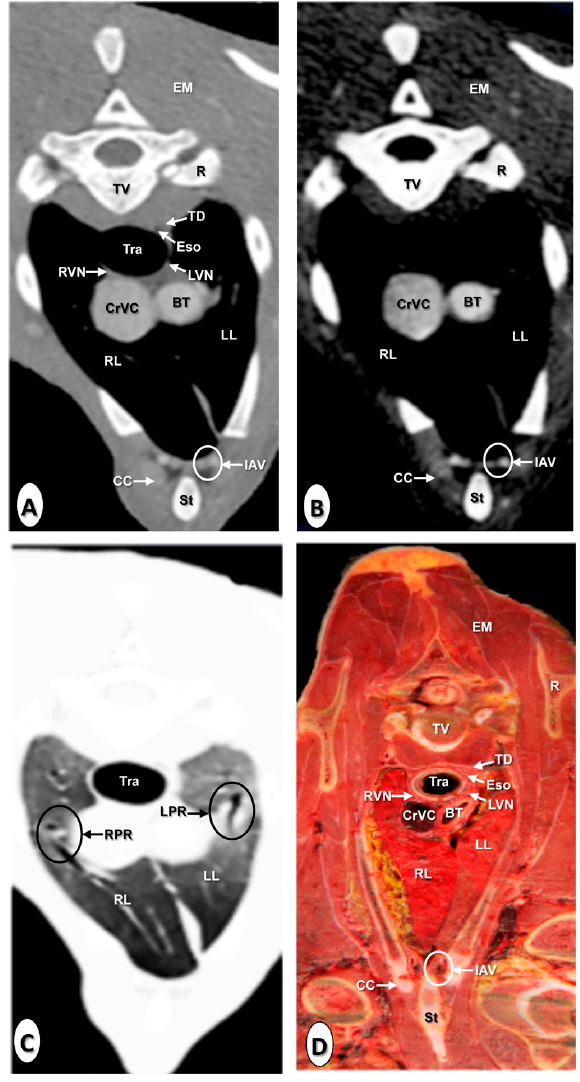
Figure 1. Transverse images at the level of the brachiocephalic trunk. ( A ) Computed tomography (CT) bone window; ( B ) CT mediastinal window; ( C ) CT lung window; and ( D ) anatomical section. These images are displayed so that the right side of the foal is to the viewer’s left and the dorsal view is at the top. Brachiocephalic trunk (BT); cranial vena cava (CrVC); epaxial muscles (EM); esophagus (Eso); internal thoracic artery and vein (IAV); left lung (LL); left pulmonary root (LPR); left vagus nerve (LVN); rib: Costal bone (R); rib: Costal cartilage (CC); right lung (RL); right pulmonary root (RPR); right vagus nerve (RVN); scapula (Sca); sternum (St); thoracic duct (TD); thoracic vertebra (TV); and trachea